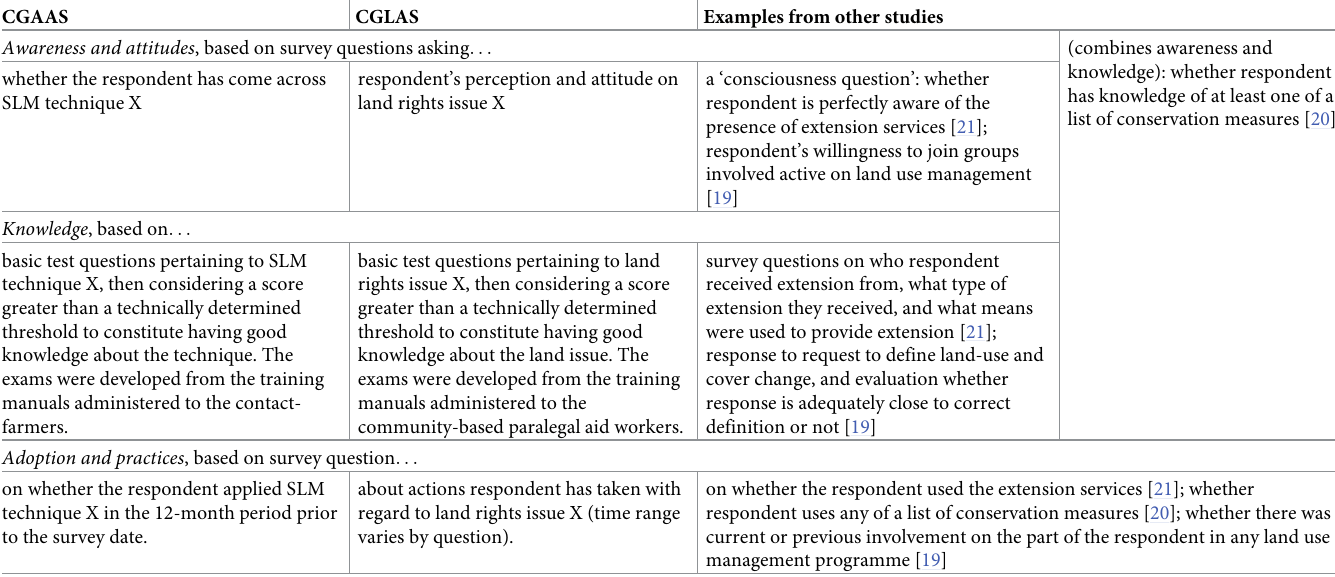
Table 5. Awareness, knowledge and adoption—definitions used in this study and in other literature. CGAAS CGLAS Examples from other studies Awareness and attitudes , based on survey questions asking